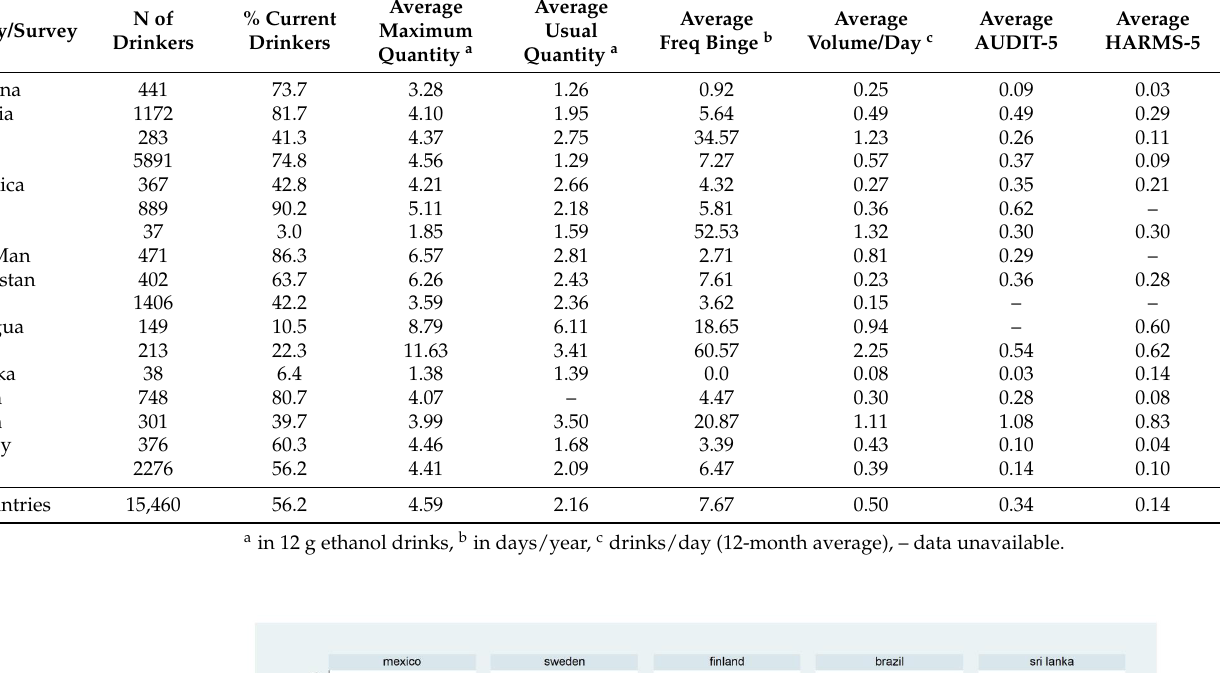
Table 3. Female Drinking and Problem Estimates.